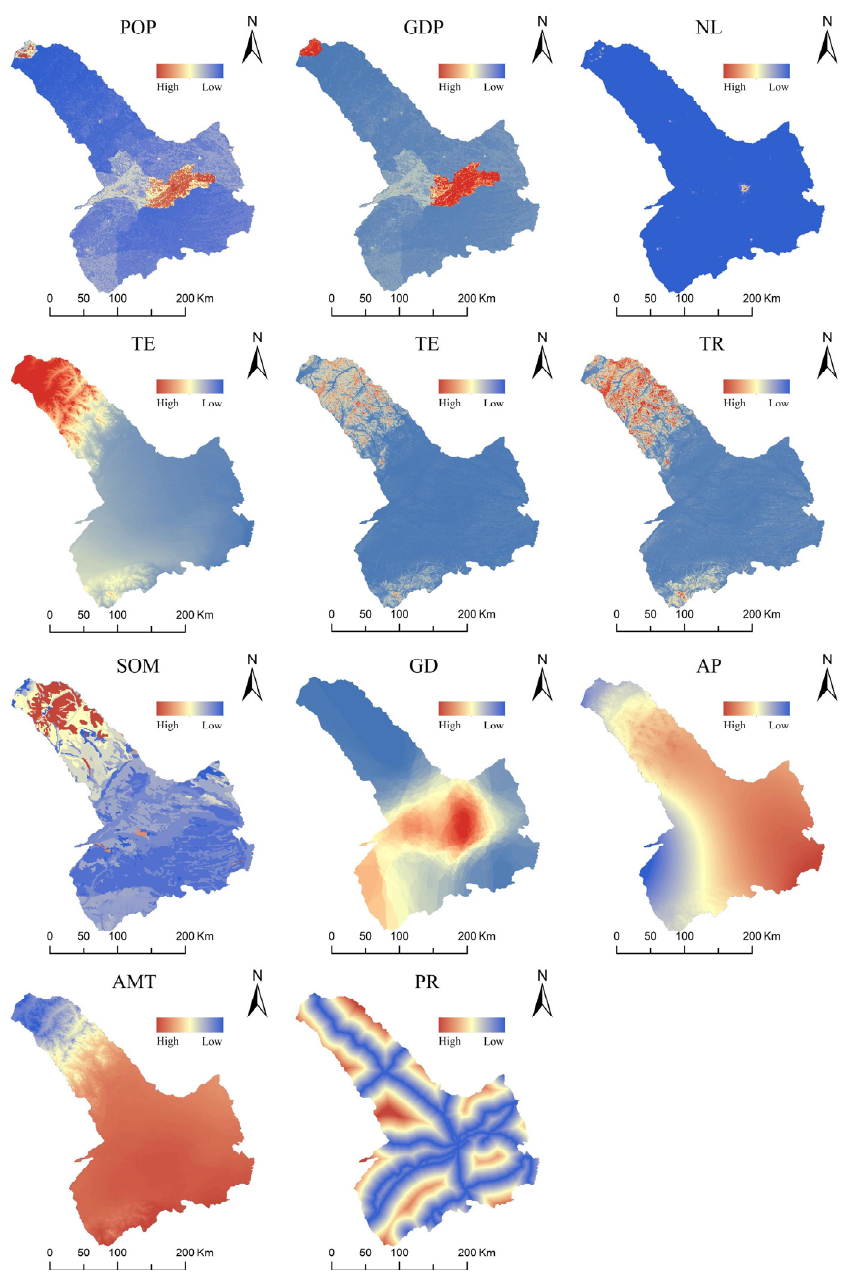
Figure A2. Distribution maps of driving factors.